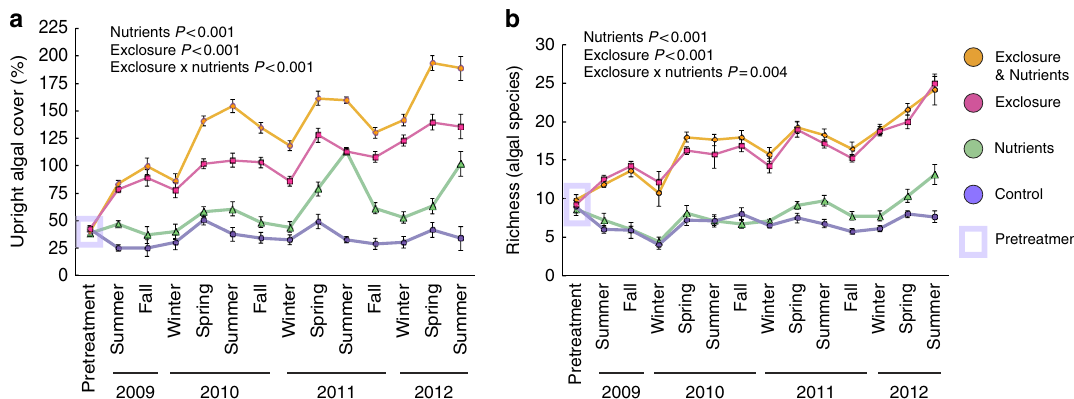
Figure 1 | Herbivore exclusion and nutrient pollution alter algal communities. ( a ) Upright algal cover (macroalgae, cyanobacteria and tall turf algae), with herbivore exclusion and/or nutrient pollution over time. Total cover often exceeds 100% due to the three-dimensional algal canopy. ( b ) Macroalgal species richness over time. P values are from mixed effect models (Supplementary Table Data 1c). Data are means